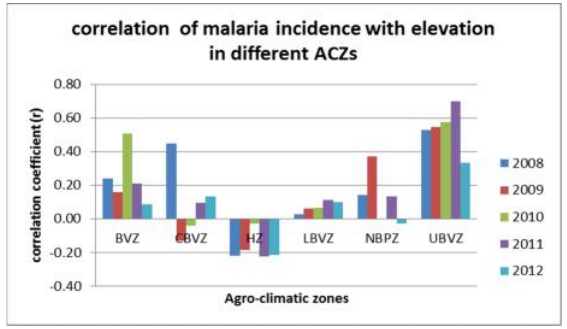
Figure 4. Correlation of malaria incidence with elevation in different agro-climatic zones of